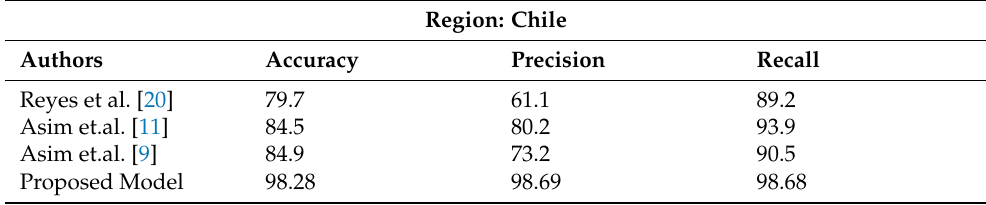
Table 9. Performance comparison of extant studies to proposed model for Chile region.